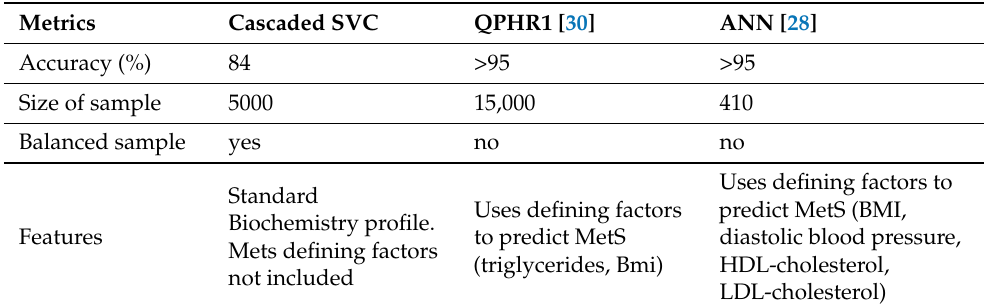
Table 2. Comparison of methodologies— MetS.